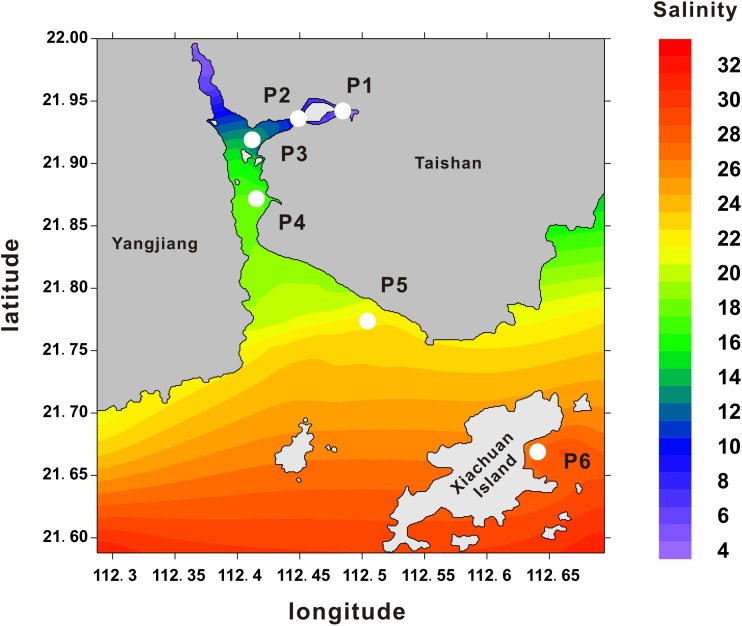
Oyster sampling locations across salinity gradients in Zhenhai Bay. Heatmap shows the average salinity (ppt) measured in different sampling areas between Shenjing town and Xiachuan Island. The salinity data were collected from the local Taishan Marine and Fisheries Agency. Numerals in the y- and x-axis indicate the coordinates in latitude and longitude, respectively.